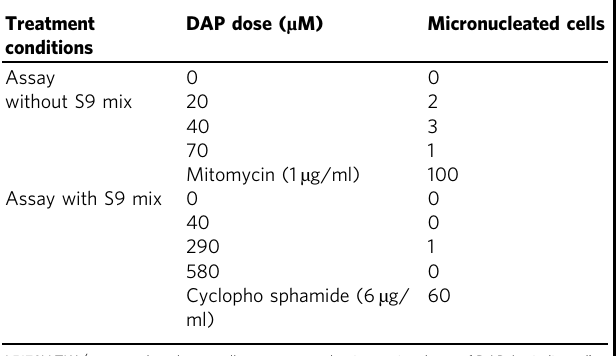
Table 1 Micronucleus induction assay.